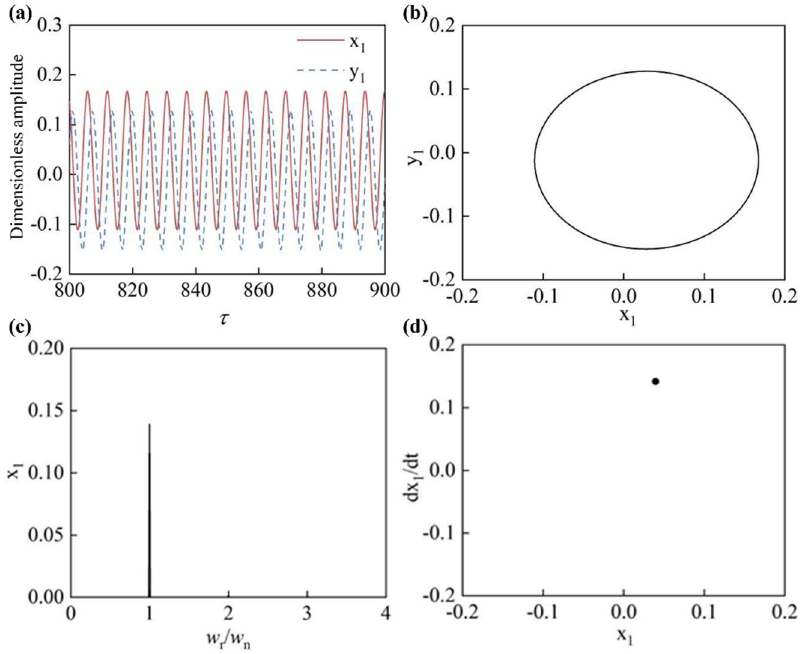
Figure 5. Rotor dynamic response under unbalanced conditions: ( a ) time domain curve of impeller displacement change; ( b ) impeller axis locus; ( c ) frequency spectrum of the impeller; ( d ) impeller poincare drawing.